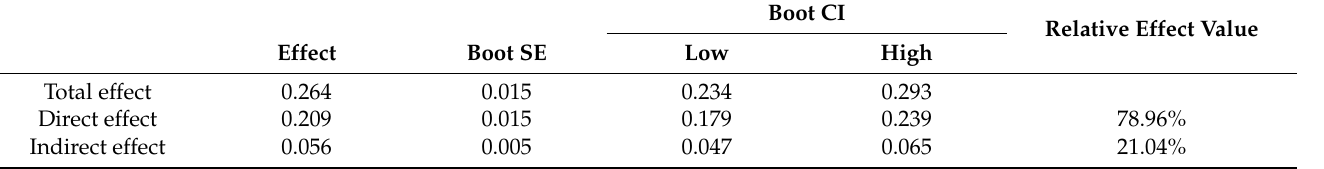
Table 4. Total effect, direct effect, and mediating